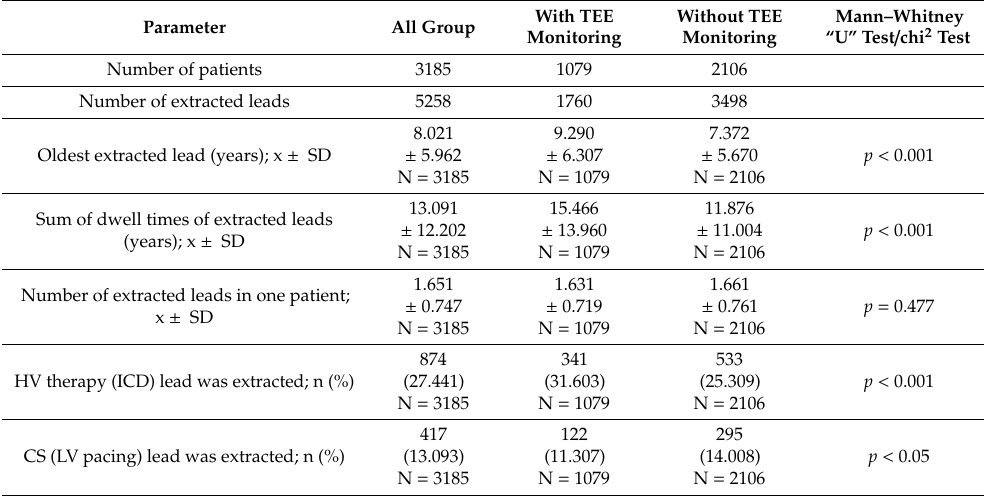
Table 4. Simulation of major complications according to the SAFeTY TLE score in the validation cohort.